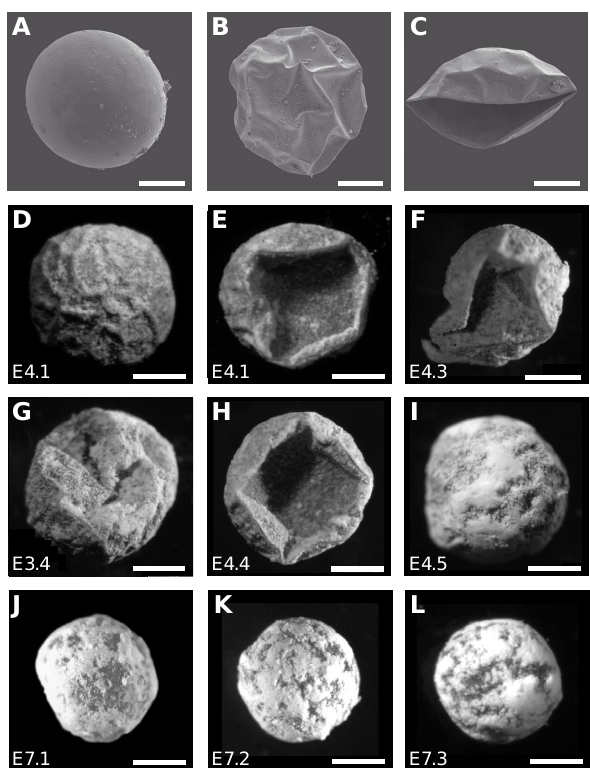
Fig. 1. Morphology preservation and mineralization of embryos. (A) – (C) Scanning electron micrographs of phosphatic embryo fos- sils from the lower Cambrian Kuanchuanpu fauna, China, and (D) – (L) light microscope micrographs of experimentally mineralized embryos of the marbled crayfish Procambarus fallax f. virginalis . (A) Smooth egg of Olivooides multisulcatus . (B) Polygonal shrink- age pattern on fossil egg. (C) Fossil embryo displaying physical degradation. (D) , (E) Experimentally mineralized embryo after 1 week, showing subtle surface mineralization, polygonal shrinkage pattern, and hemispherical internal collapse. (F) Completely min- eralized and shrunken embryo after 3 weeks, and (G) , (H) after 4 weeks. (I) Dense crystal accumulations appear after 5 weeks. (J) – (L) Pre-heated crayfish embryos retain their globular morphology and exhibit complete mineralization of the outer membrane after 1, 2 and 3 weeks (scale bar: (A) and (B) =200µm; (C) =300µm; (D) – (L) =500µm; and E4.1, E4.3, etc.=experiment